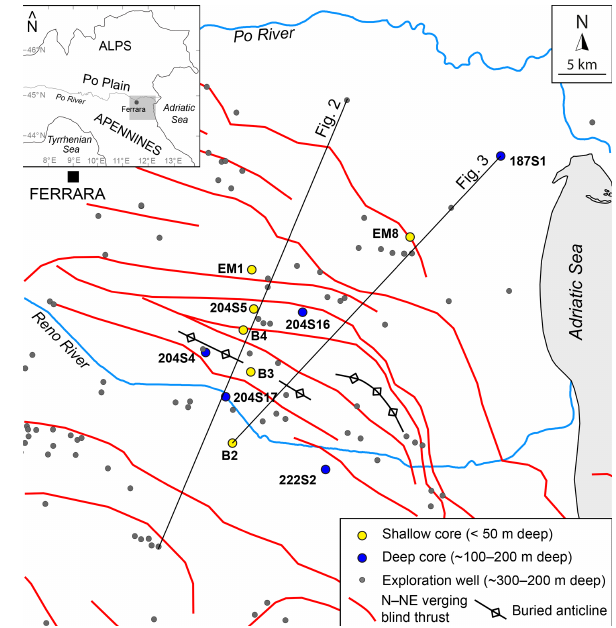
Figure 1. Study area with location of cores, exploration wells and cross sections of Figs. 2 and 3. The projection of north-verging buried thrusts is